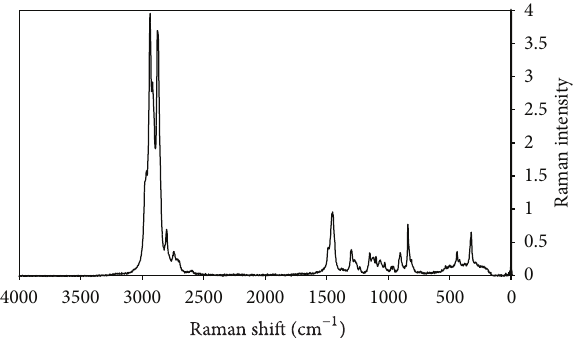
F 4: Raman spectrum of liquid NBEE.